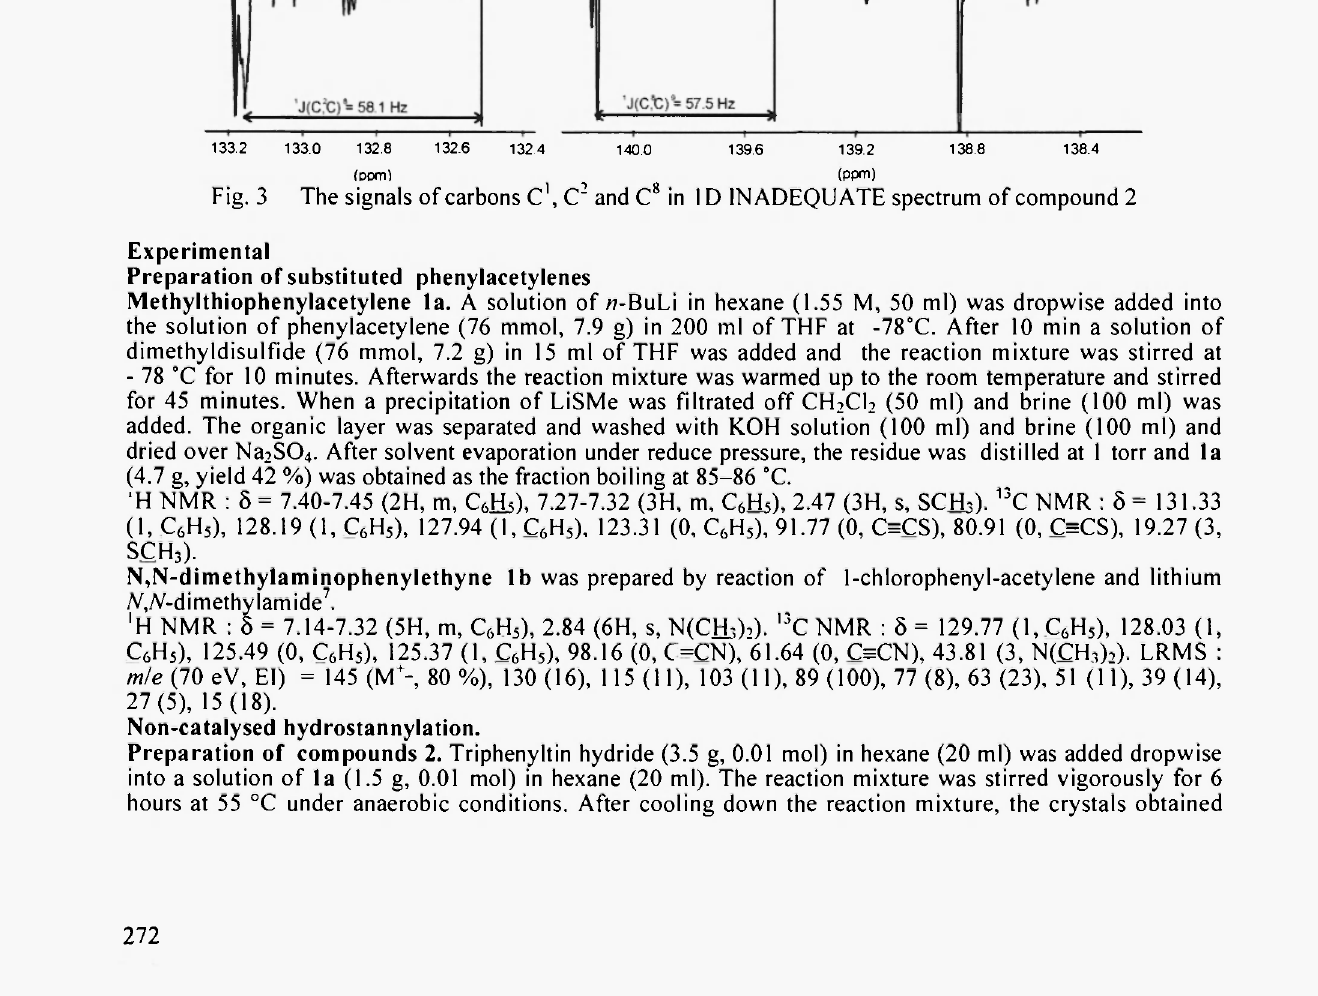
Fig. 2 Part of NOESY spectrum of compound 3